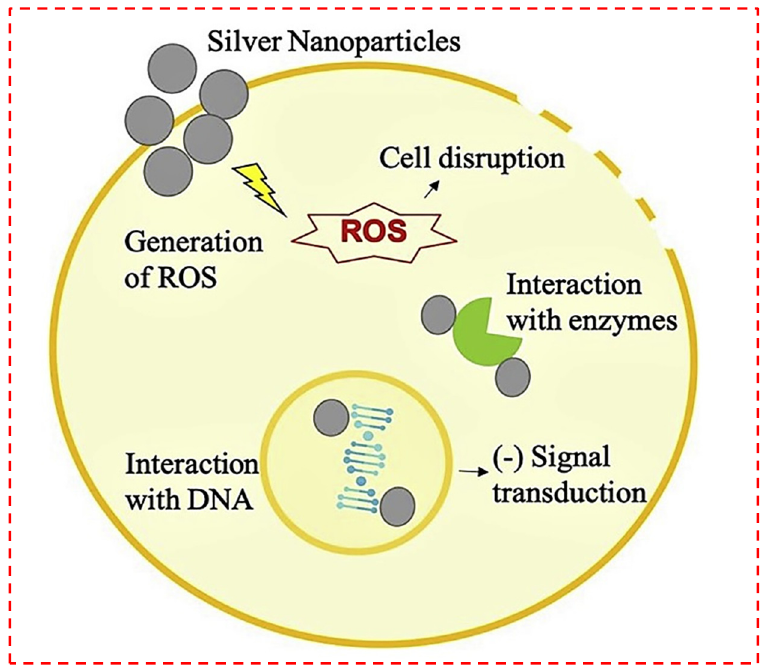
Figure 3. The schematic illustration of feasible antibacterial mechanisms of Ag nanoparticles (AgNPs) [46].